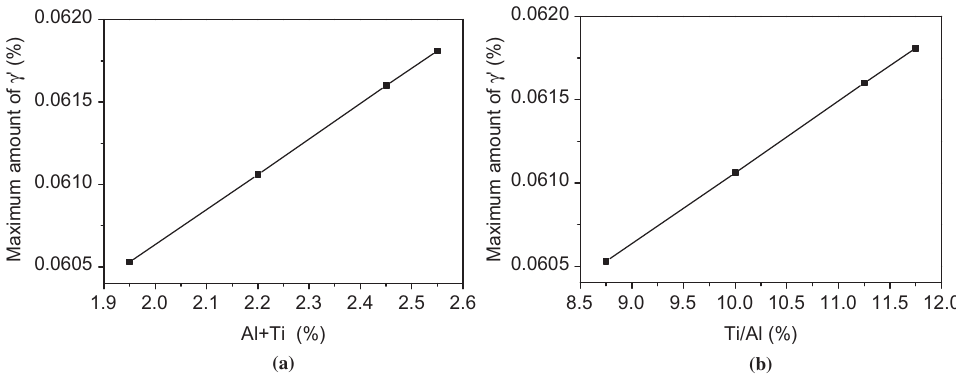
Figure 12: Influence of Al + Ti contents (a) and Ti/Al ratio (b) on maximum amount of γ ′ phase.